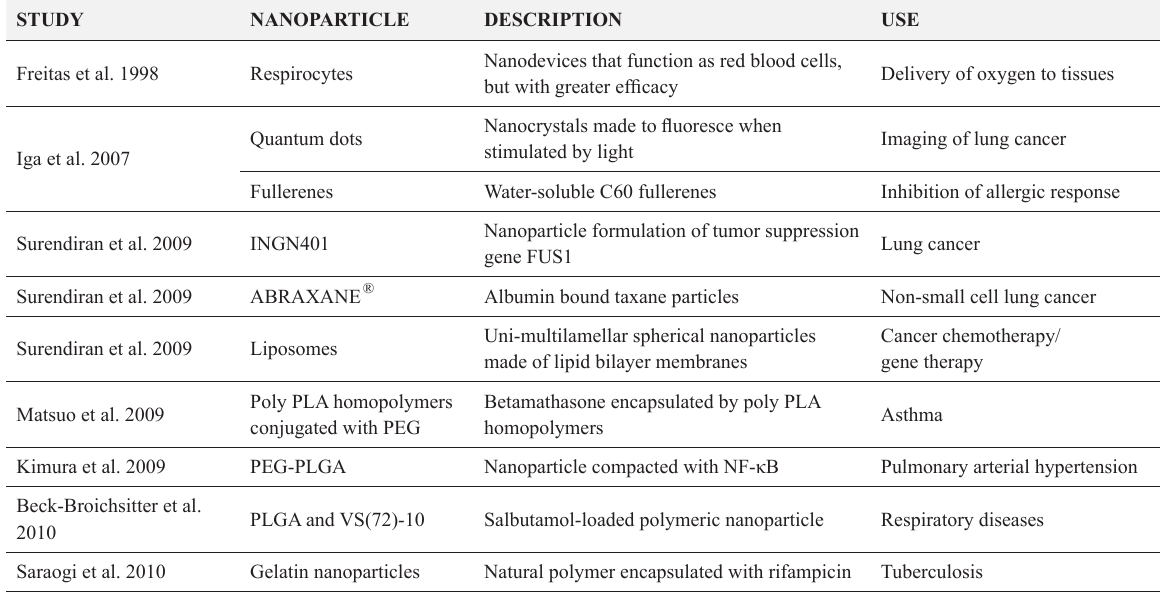
Nanoparticles used for respiratory